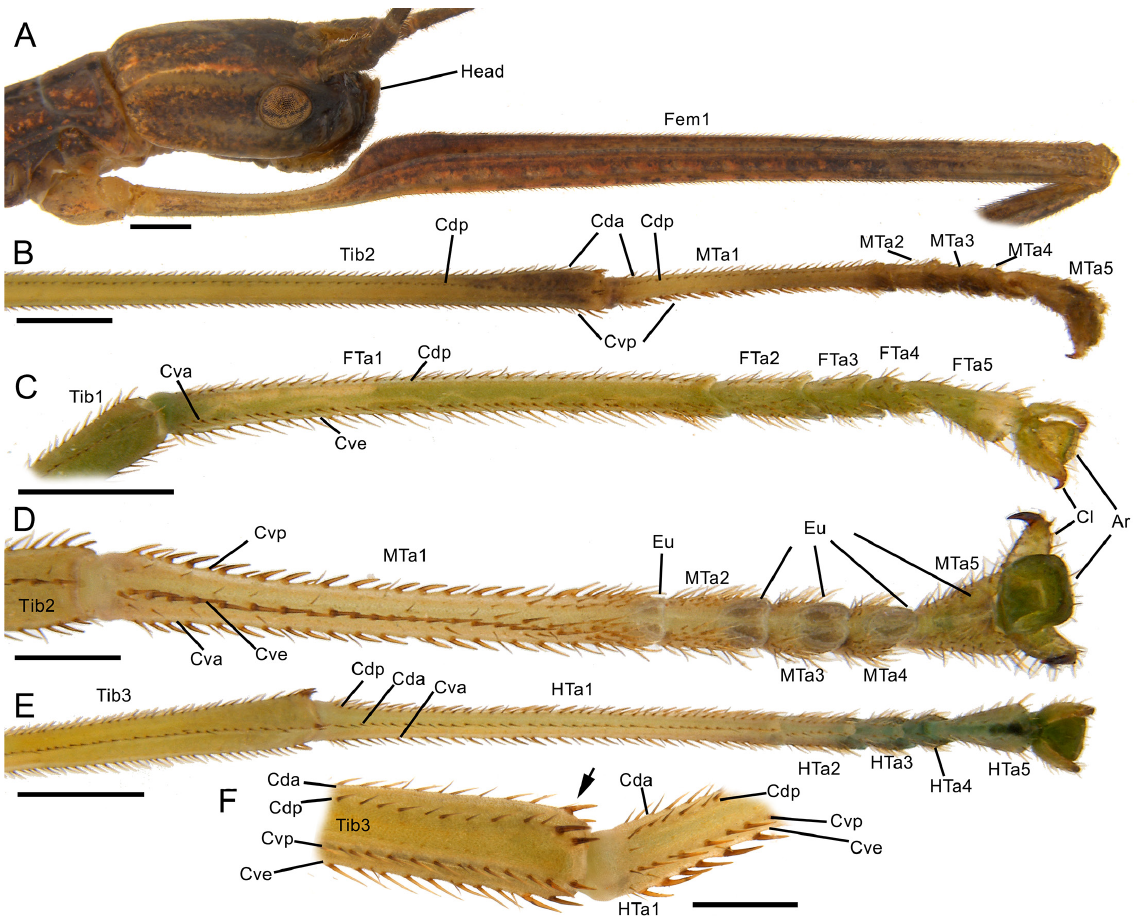
Fig. 6. Leg morphology of Arumatia dubia (Caudell, 1904) gen. et comb. nov. A–B . Adult ♀ (MZUSP V0547) from Araguari, Minas Gerais, Brazil. C–F . Adult ♀ (MZUSP V0534) from Chapadão do Sul, Mato Grosso do Sul, Brazil. A . Anterior region of body and fore leg, lateral view. B . Apex of left midleg (mirrored), retrolateral view. C . Left fore tarsus, retrolateral view. D . Right mid tarsus, ventral view. E . Right hind tarsus (mirrored), dorsal view. F . Detail of apex of right hind tibia showing stronger apical spines (arrow), retrolateral view. Abbreviations: Ar = arolium; Cda = dorsal anterior carina; Cdp = dorsal posterior carina; Cl = claw; Cva = ventral anterior carina; Cve = ventral carina; Cvp = ventral posterior carina; Eu = euplantula; Fem = femur; FTa = fore tarsomere; HTa = hind tarsomere; MTa = mid tarsomere; Tib = tibia. Scale bars: A–C, E = 1 mm; D, F = 0.5